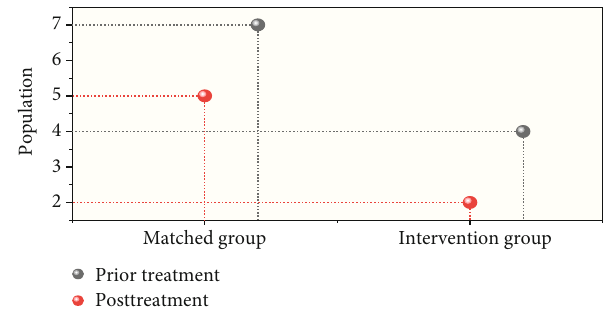
Figure 9: The occurrence of acute injury in